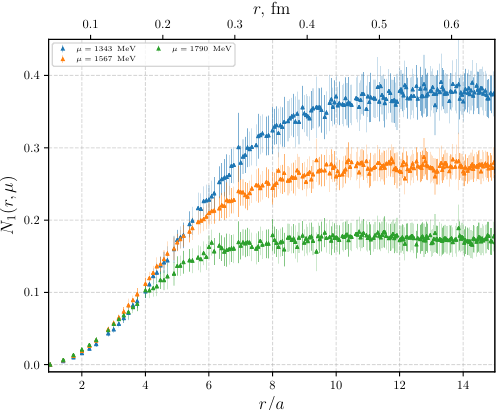
Figure 7 . The quark number N 1 ( r; (cid:22) ) induced by a static quark-antiquark pair as a function of distance for few values of chemical potential.